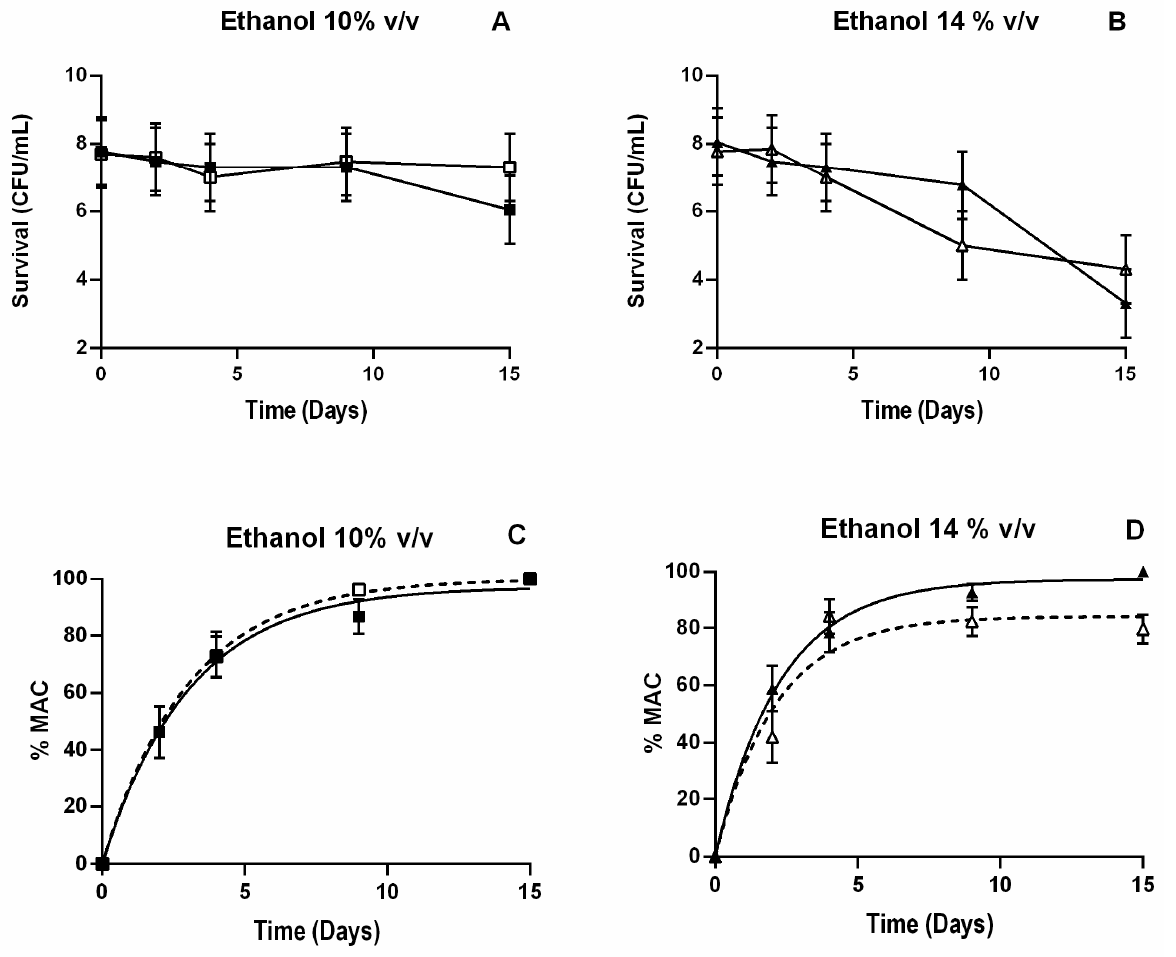
Figure 5. Survival of the Lcb. paracasei UNQLpc 10 strain ( A , B ) (filled symbols: previously acclimated culture, empty symbols: non-acclimated culture) and percentage of L-malic acid consumption (% MAC) during malolactic fermentation (MLF) ( C , D ) in synthetic wine with 10 or 14% v / v ethanol (filled symbols: previously acclimated culture, empty symbols: non-acclimated culture). Data are shown as mean ± SD of two independent measurements.